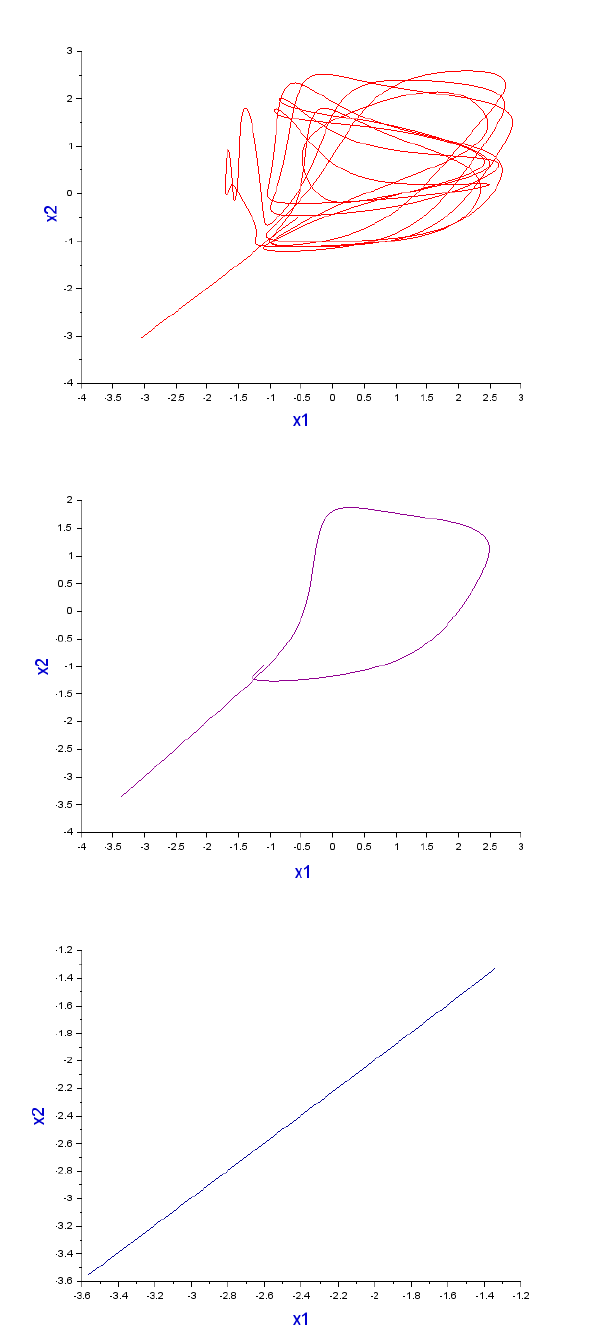
Figure 4. Synchronization between the master-slave HR neurons sys- tems: plots of x 2 according to x 1 at various coupling strengths k = 0 . 05 , 0 . 08 , 0 . 17, 0 . 19 and 0 .